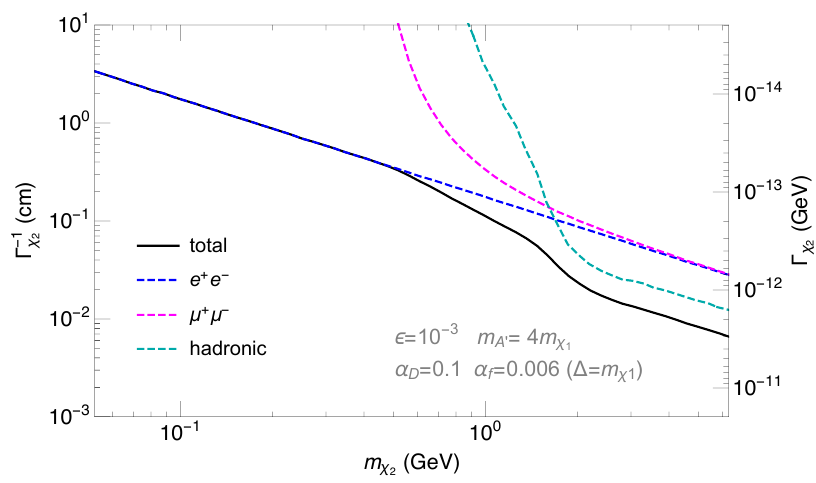
Figure 8 . χ 2 decay length together with the leptonic and the hadronic contributions for the parameters of figure 5